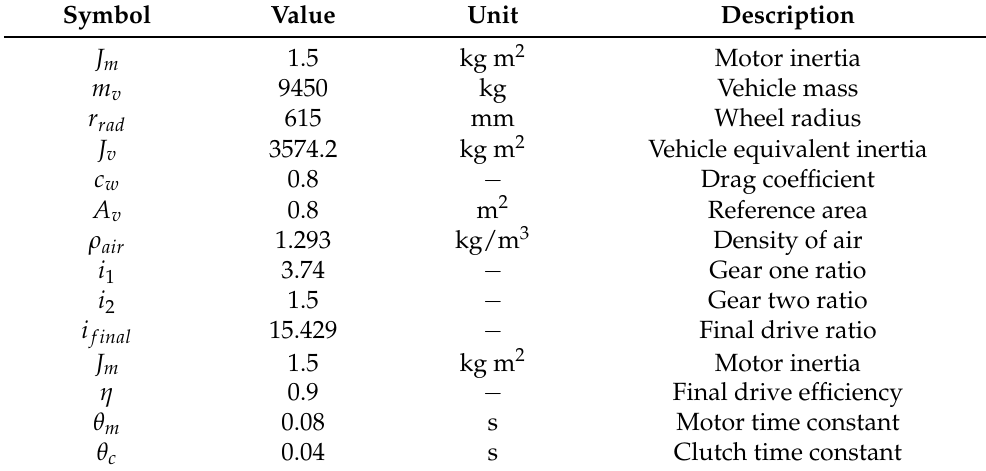
Table A1. Vehicle model